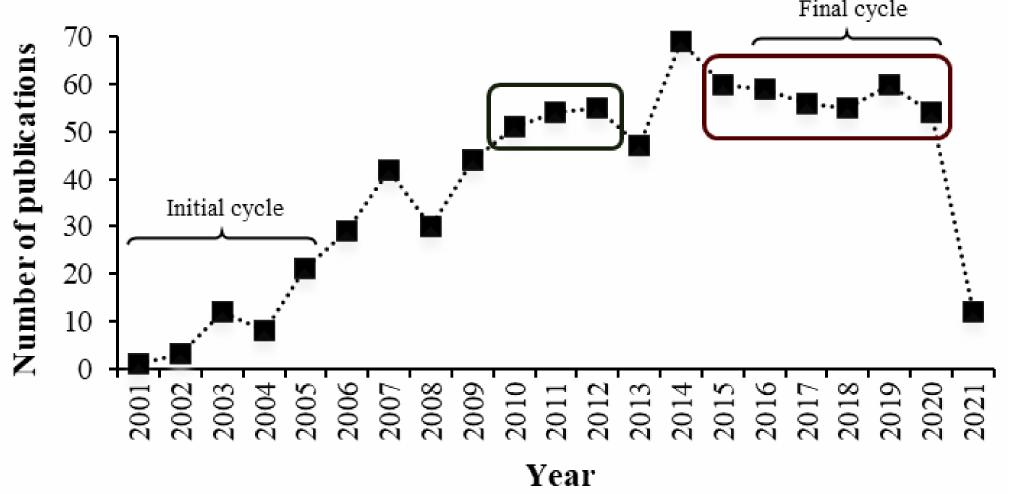
Figure 2. Annual number of scientific publications identified in the SciELO database. The search strategy was (“essential oil” OR extract) AND